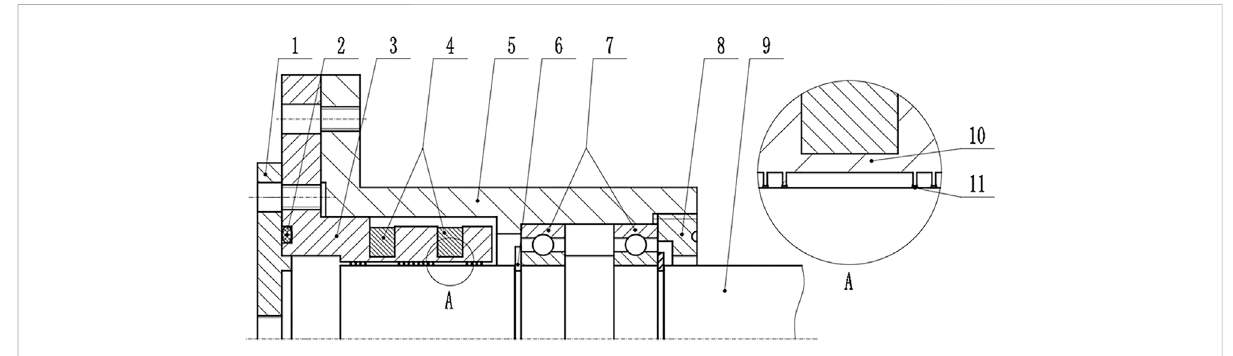
FIGURE 2 Magnetic fl uidsealing device. 1-upper end cover, 2-sealing ring, 3-integrated pole shoe, 4-shell, 5-permanent magnet, 6-circlip, 7-bearing, 8- lower end cover, 9-rotation shaft,10-thin wall, 11-magnetic fl uid.